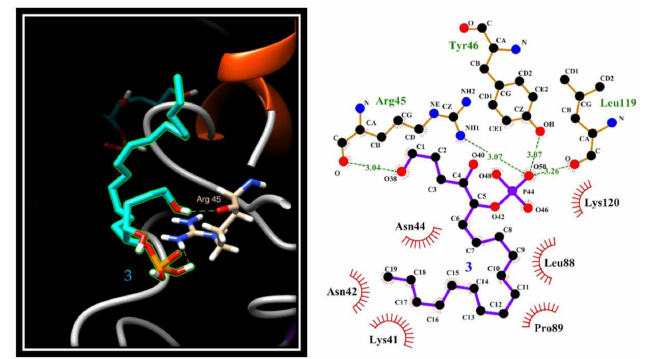
Figure 10. Interaction of compound 3 with the region lining the active site of